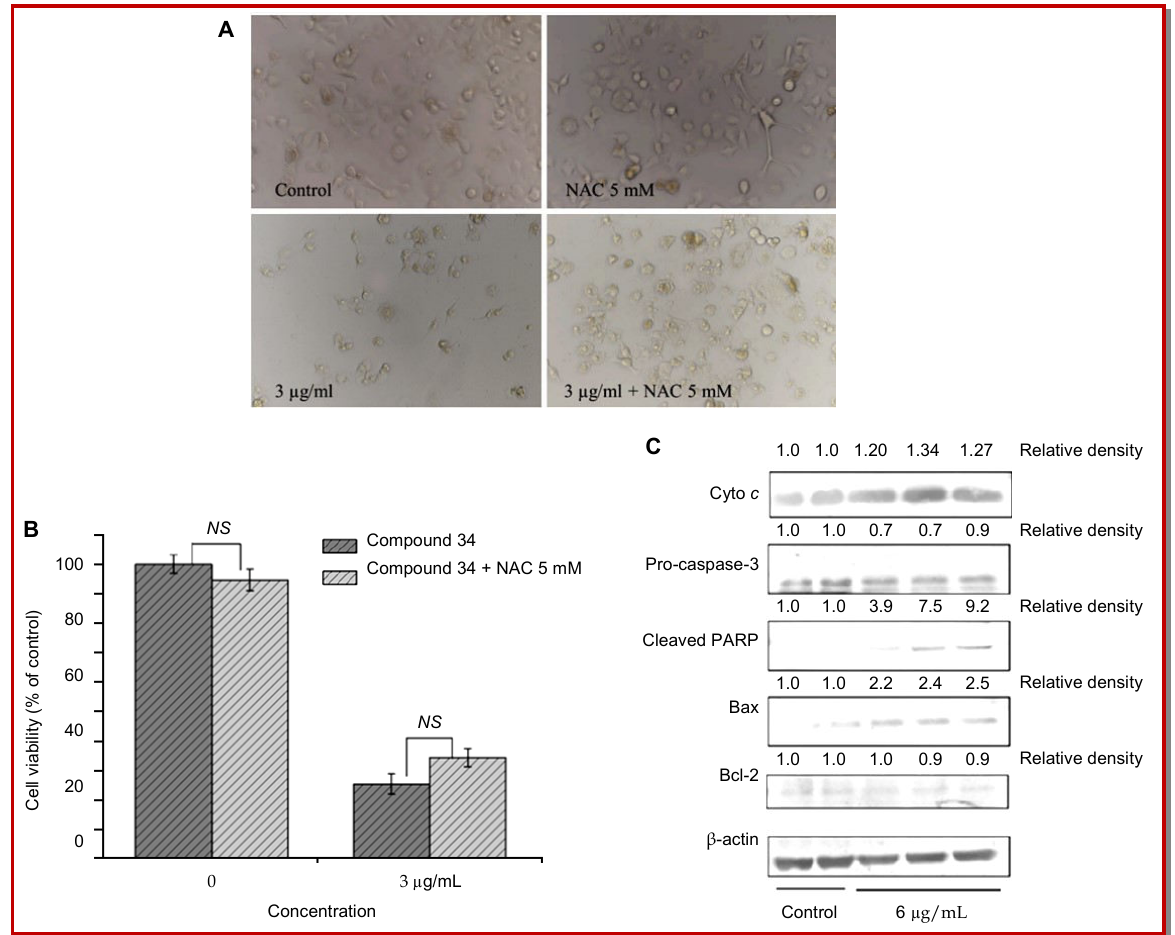
Figure 5: Compound 34 induces ROS-independent intrinsic apoptosis (A) and (B) Cells were treated with 3 µg/mL compound 34 for 12 hours and then pre-incubated with 5 mM NAC for 4 hours before MTT assay or morphological observation. (C) Cells were treated with indicated concentrations of compound 34 for 12 hours, followed by Western blot analysis with indicated antibodies. β - actin was used as a loading control. NS means no statistical significance, p>0.05